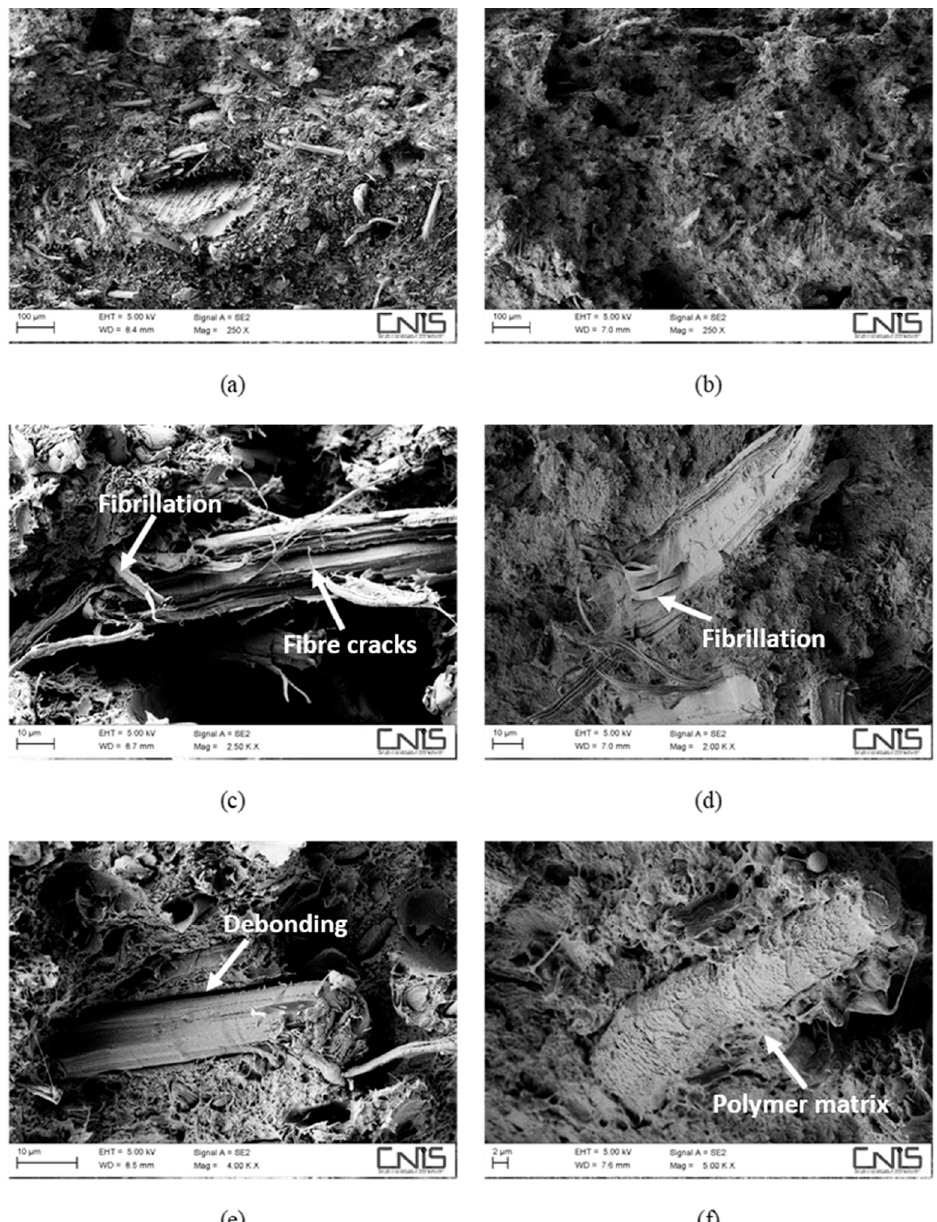
Figure 3. SEM micrographs detailing the fracture surface of water-aged composites, reinforced with 30 wt % of hemp fibres without ( a , c , e ) and with ( b , d , f ) a coupling